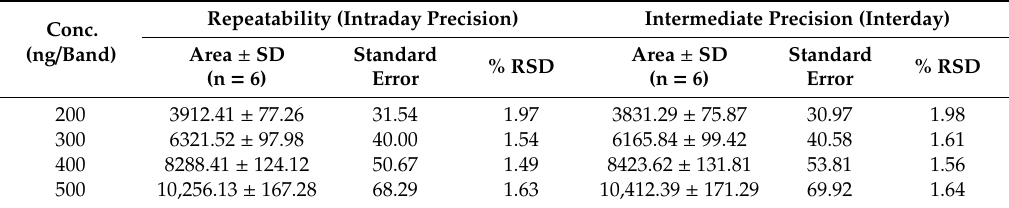
Table 4. Precision data of HPTLC method (mean ± SD; n =